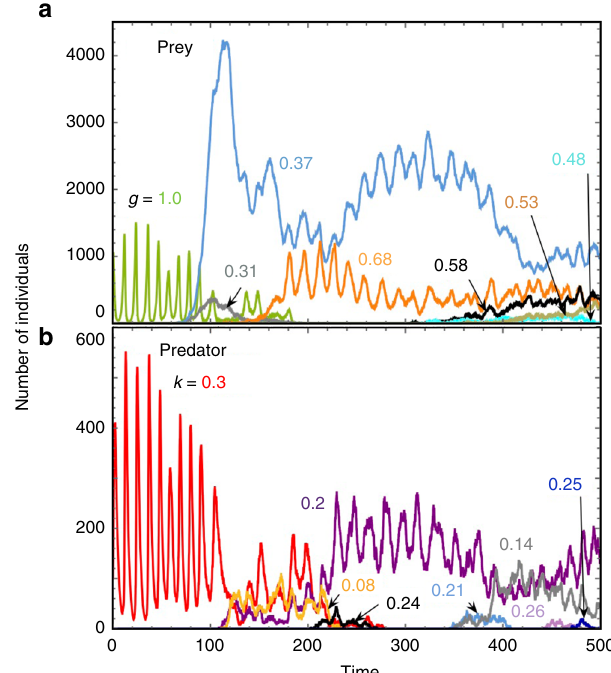
Fig. 4 Stochastic coevolutionary dynamics of the prey and predator species. Different prey ( a ) and predator ( b ) types coexist with each other. The ancestor prey ( g 1 = g max = 1.0) and the ancestor predator ( k 1 = k max = 0.3) follow classical predator-prey cycles. New prey and predator types arise by de novo mutations. Some prey and predators invade and are maintained until they ultimately are lost again. Their g and k values are marked beside the corresponding types (parameters b x = 1.0, d x = 0.1, μ = 0.0001, r = 0.00005, X = 1000, Y = 100, d = 0.5, μ = x c 1 (0) 1 (0) y y